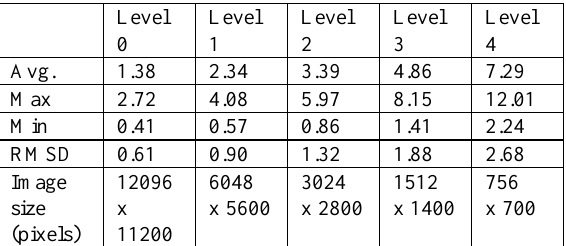
Table 2. Key point density (unit: points / 1000pixels) for the 108 test images on different level of image pyramid